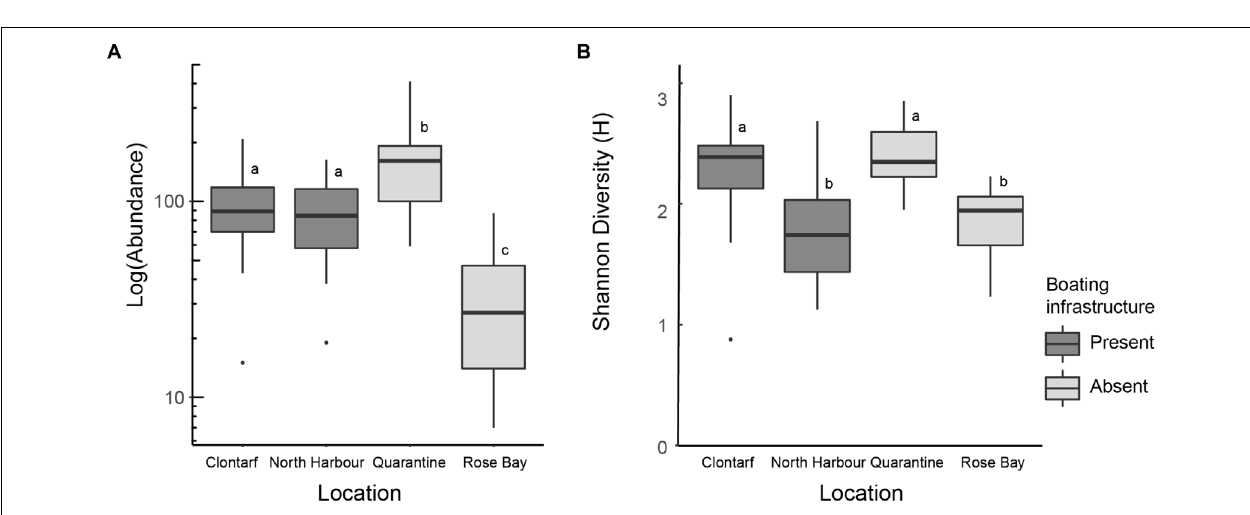
infrastructure (Quarantine Bay and Rose Bay). In